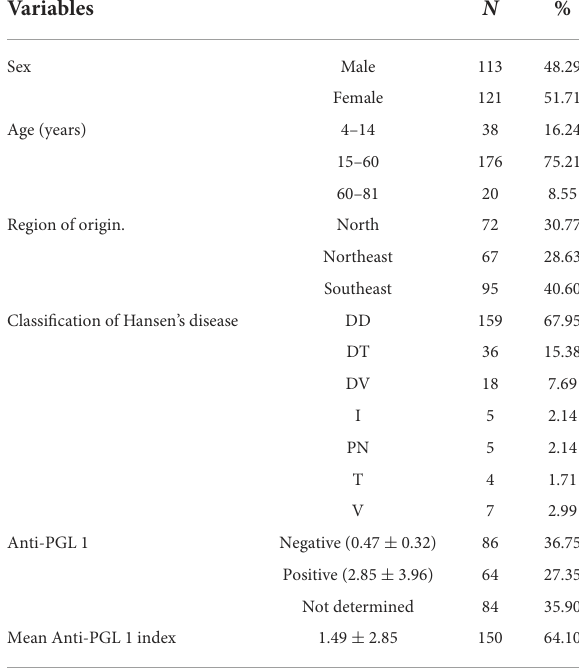
TABLE 1 Distribution of the population sample by sex, age range, state of origin, operational classification, and anti-PGL 1 data.